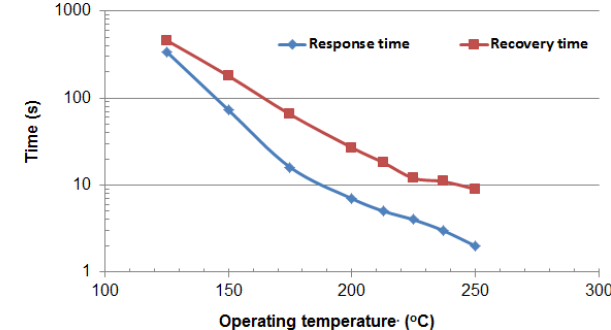
Figure 15. Dependence of the response and recovery times of MWCNTs/SnO 2 FA vapor sensor on operating temperature.